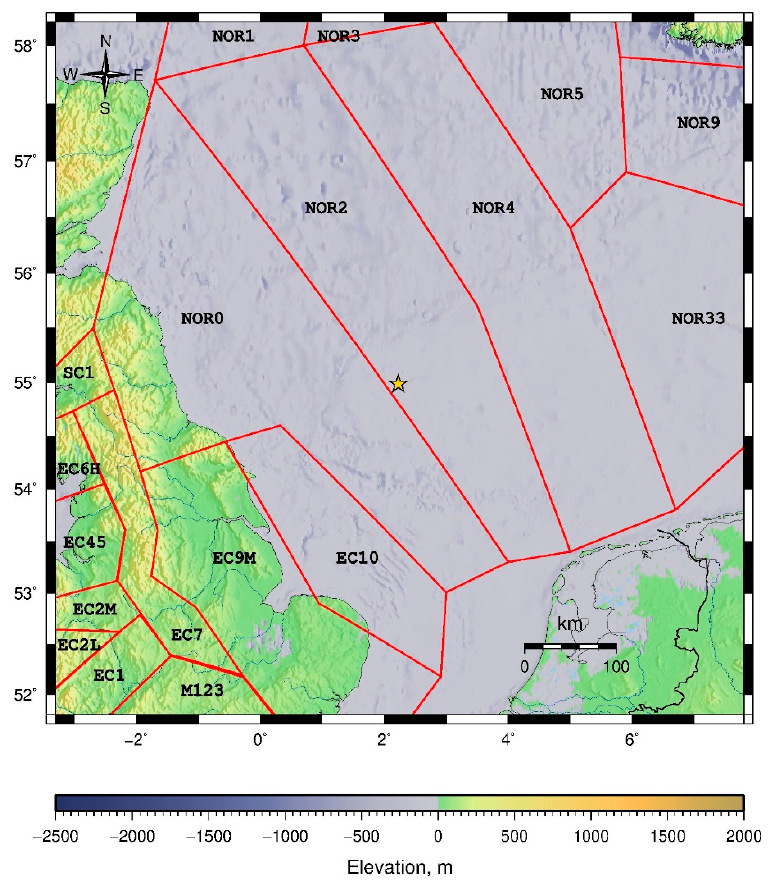
Figure 1. Location of areal source zones for SSM1 based on Bungum et al. [6] and Musson and Ser- geant [23]. The yellow star indicates the center of the wind farm zone.